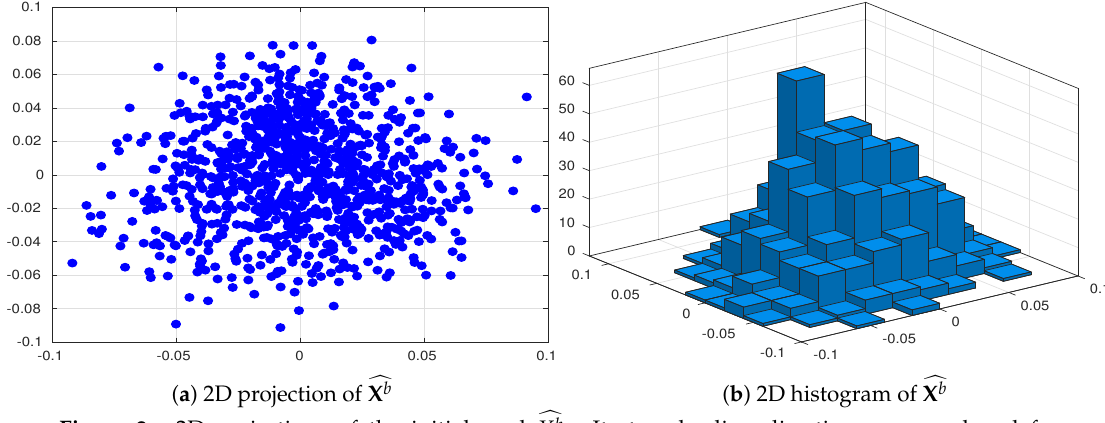
Figure 2. 2D projections of the initial pool (cid:99) X b . Its two leading directions are employed for the